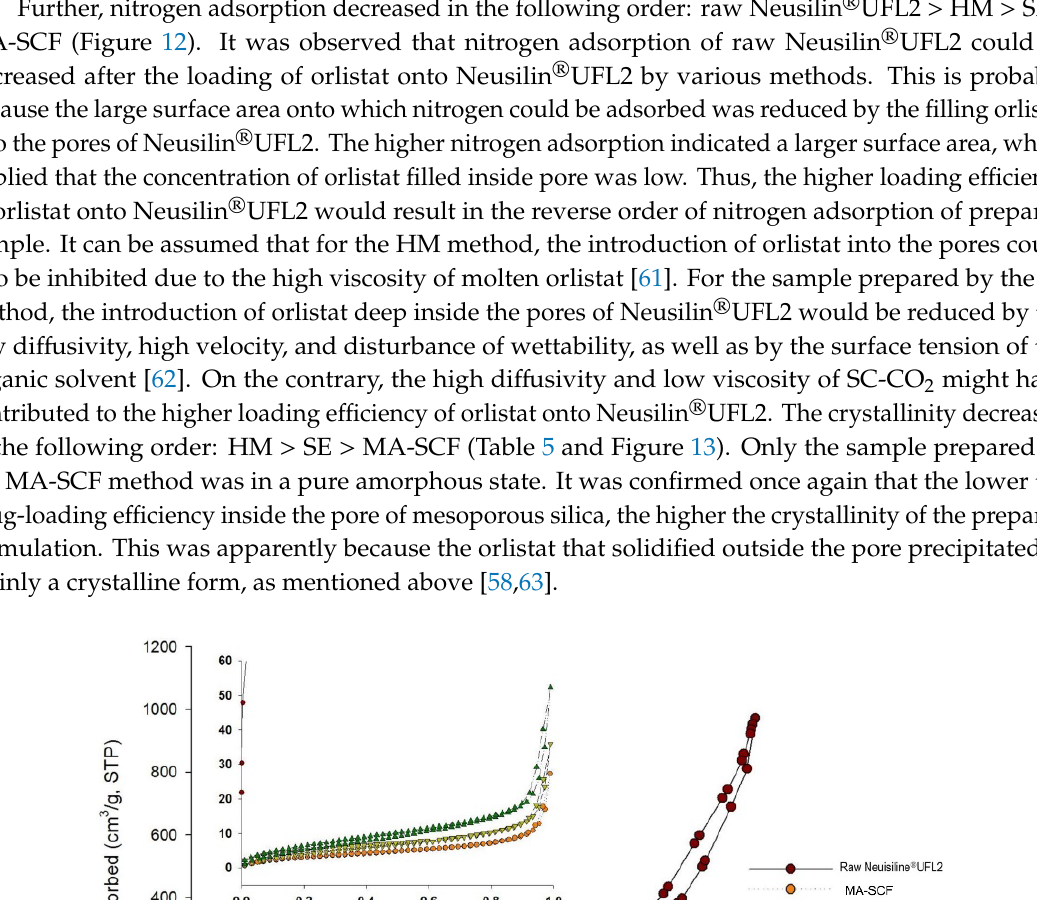
Table 5. Evaluated pharmaceutical characteristics of orlistat-loaded Neusilin ® UFL2 prepared by various methods.